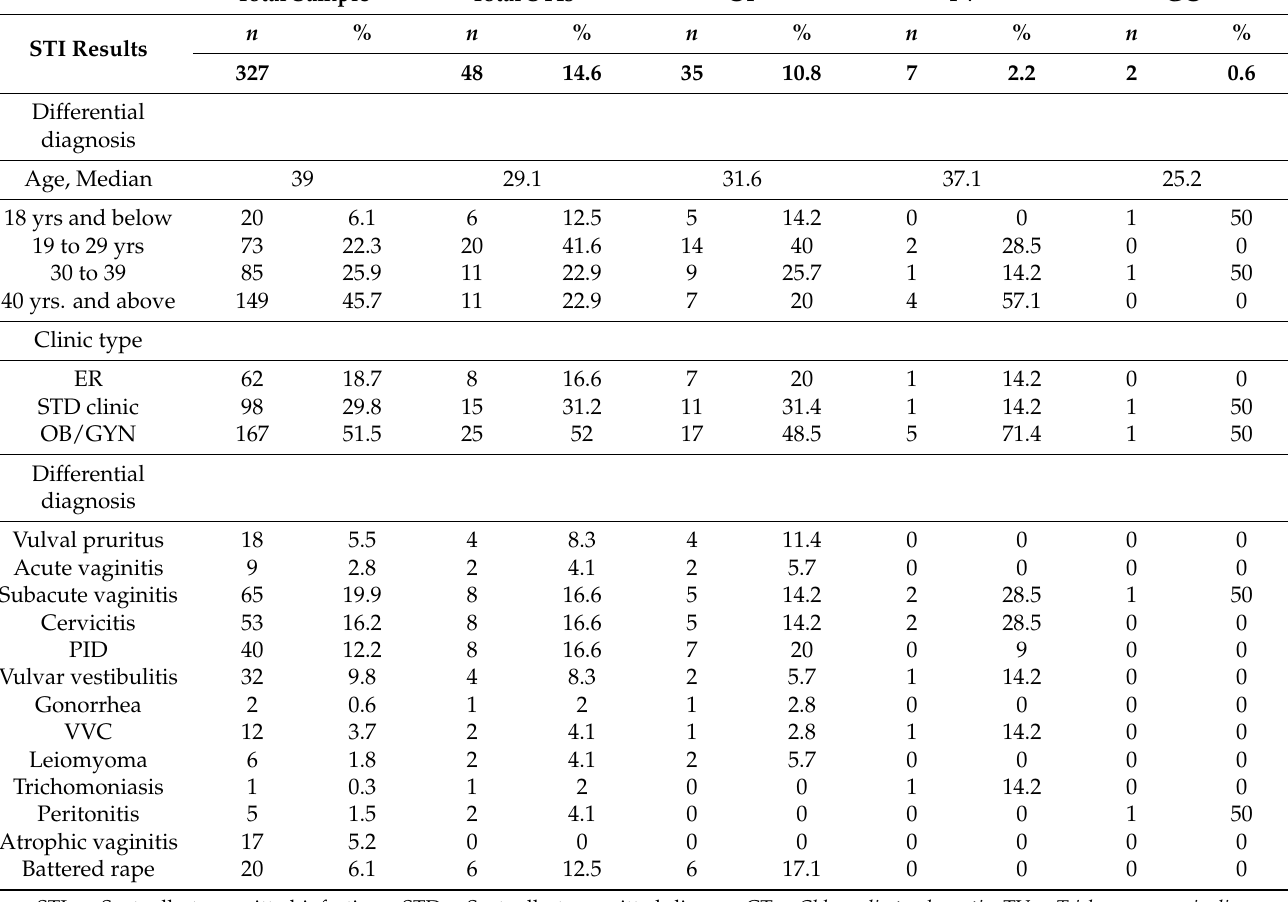
Table 1. Demographic information, clinic type, differential diagnosis and prevalence of STIs in this study. Total